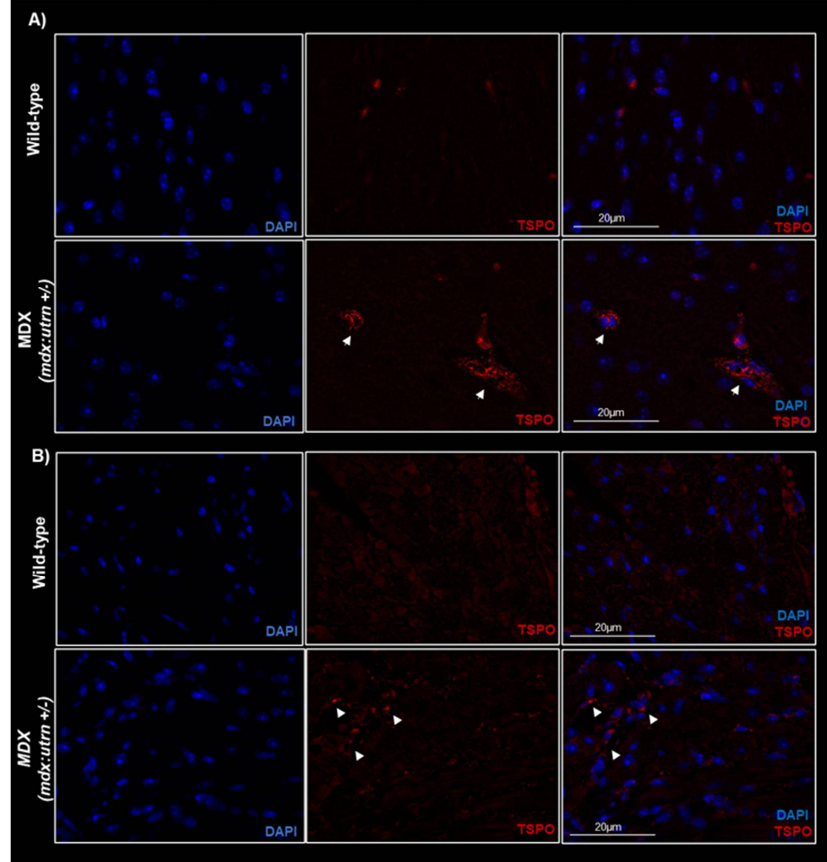
Figure 5. Ex vivo histology of TSPO-bound microglial and macrophages in an MDX and wild-type mice cardiac (A) and neural tissues (B). Representative fluorescence immunostained images of microglial and macrophages with TSPO (red) and DAPI (blue) in 8–10 weeks old mdx:utrn (+/ − ) mice depict qualitatively more prevalent TSPO expression in the dystrophin-deficient mice. White arrow heads indicate regions of TSPO signal. Scale bar overlaid on merged (DAPI and TSPO) images = 20 µ m in length. Translocator protein, MDX = dystrophin-deficient mdx:utrn (+/ − ) mouse